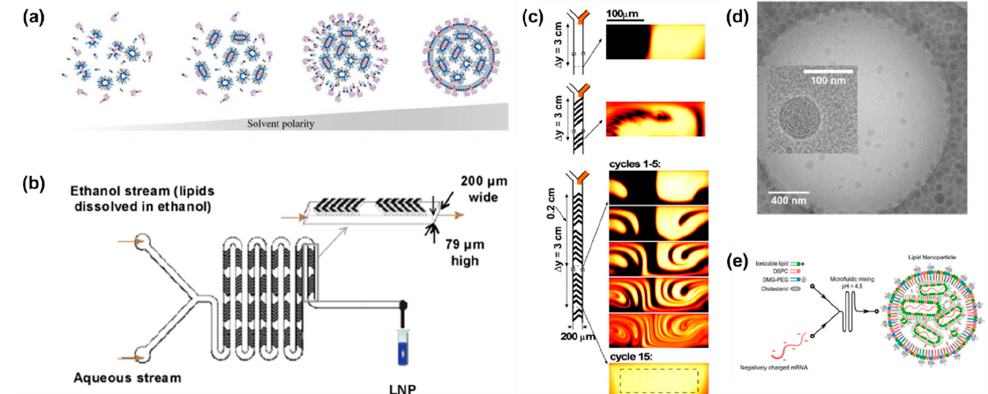
Figure 5. ( a ) Schematic diagram of mechanism for LNPs preparation by nanoprecipitation. When lipid-laden organic solvents and RNA-laden aqueous solutions are intermixed, ionizable lipids and negatively charged nucleic acids bind to each other via electrostatic interactions to form the core, and other lipids cover the surface to form lipid monolayers. Reproduced with permission [87]. Copyright 2018, Wiley. ( b ) Schematic illustration of LNPs preparation by SHM. Lipid-laden ethanol is introduced through one inlet of the SHM, whereas aqueous solution is introduced through the other inlet. Reproduced with permission [89]. Copyright 2012, American Chemical Society. ( c ) Schematic illustration of channel mixing behaviors for wall-less structures, straight ridges, and interlaced herringbone structures. Reproduced with permission [90]. Copyright 2002, American Association for the Advancement of Science. ( d ) Cryo-transmission electron microscopy images of LNPs-siRNA, showing an electron-dense core structure. Reproduced with permission [93]. Copyright 2012, American Chemical Society. ( e ) Schematic illustration of RBD-hFc mRNA LNP synthesis. Reproduced with permission [97]. Copyright 2020, American Chemical